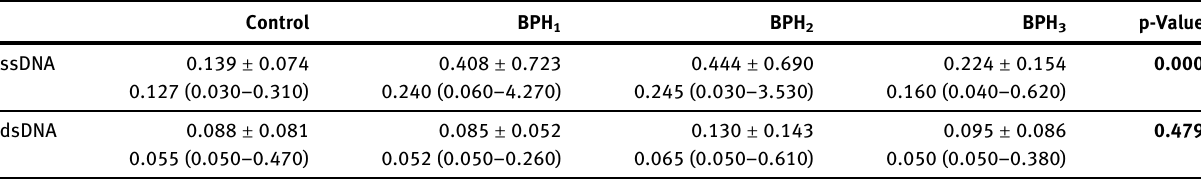
Table  : Descriptive statistics of the DNA amounts in the control, preoperative (BPH  ) and postoperative (BPH  and BPH  ) samples of the patients. DNA concentrations were calculated in ng/ μ L. Data are presented as mean ± standard deviation and median (minimum – maximum) values.